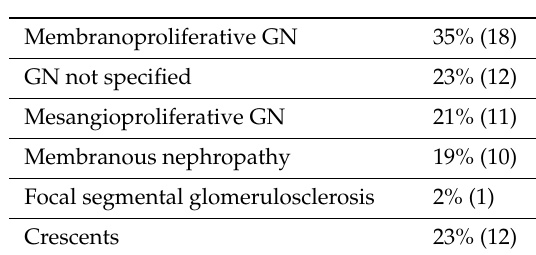
Table 5. Patterns of kidney lesions HUVS-KI ( n = 52).